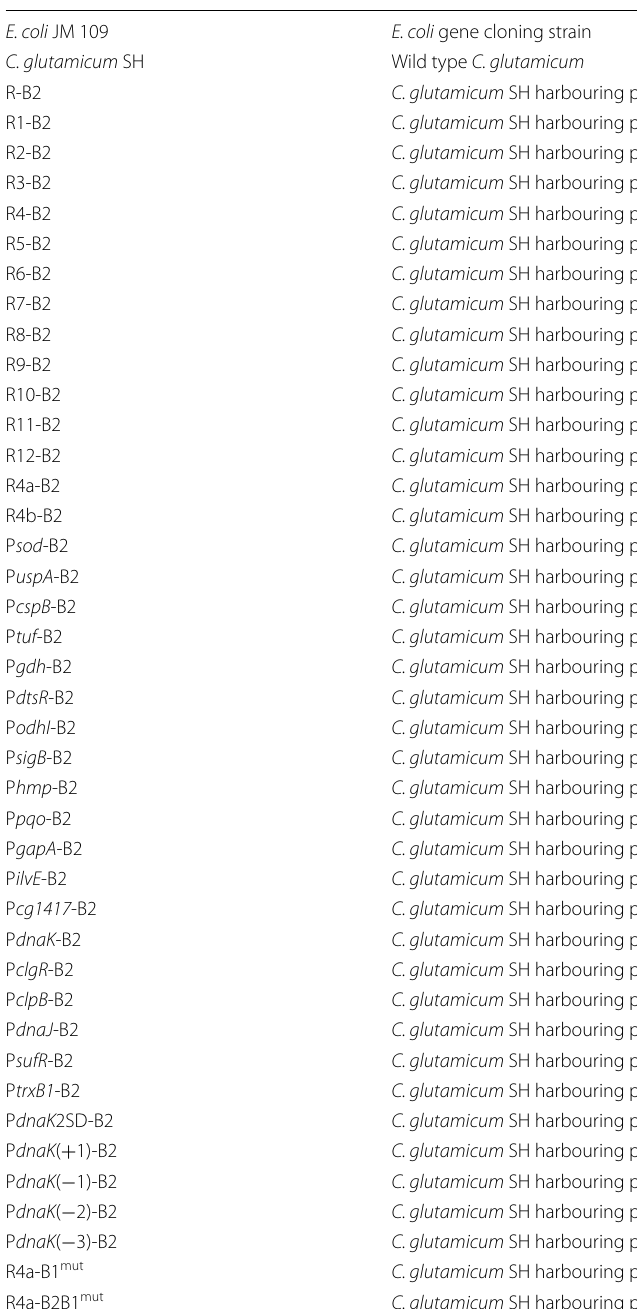
Table 1 Strains use in this study Strains